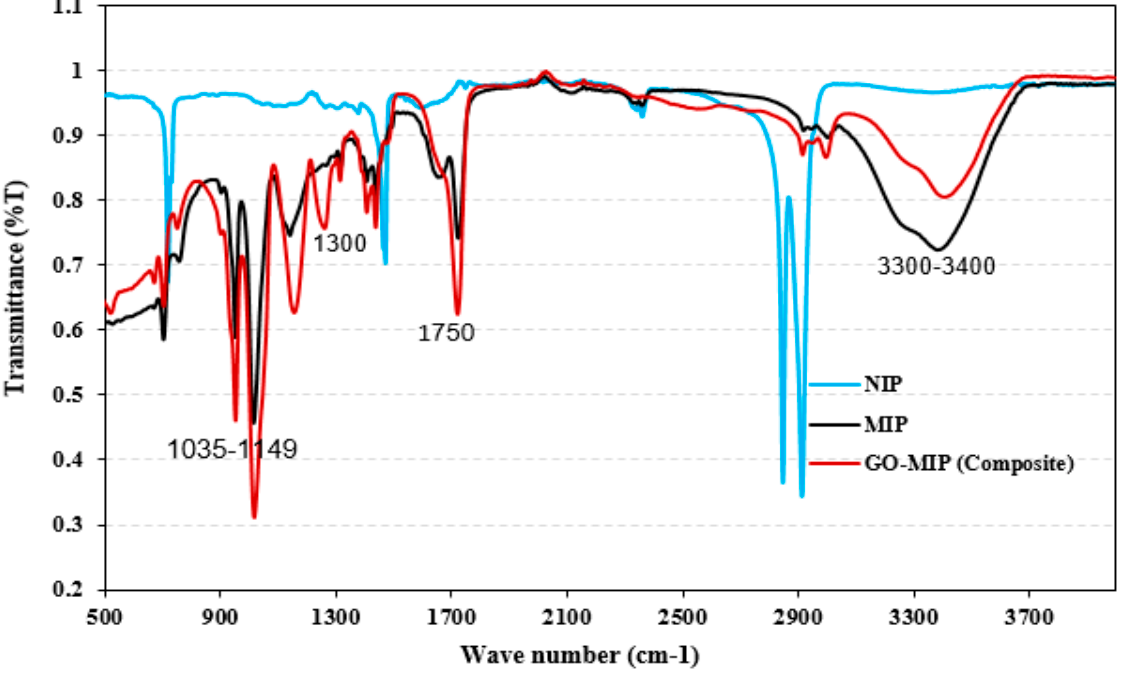
Figure 3. FT − IR spectra of sucrose receptors (NIP, MIP, and GO-MIP). The thermogravimetric and differential thermal analysis (TGA/DTA) curves of (a) NIP, (b) MIP, and (c) GO-MIP are presented in Figure 4, with a temperature variation of 10 ◦ C/min, and temperature range of 60 ◦ C to 600 ◦ C. The first weight loss occurred between 23.33 ◦ C and 302.75 ◦ C, resulting in an initial mass loss of − 1.759 g. Dehydration stage has a temperature range of 305.10 ◦ C to 591.69 ◦ C with a weight loss of − 4.007 mg.